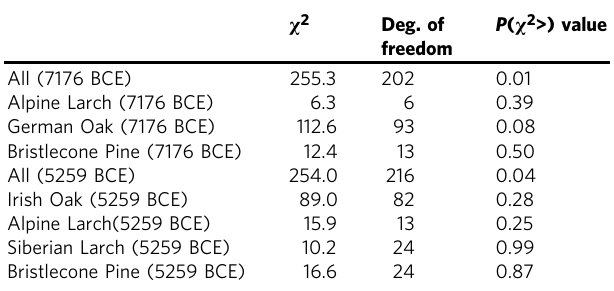
χ 2 Deg. of P ( χ 2 >) value freedom